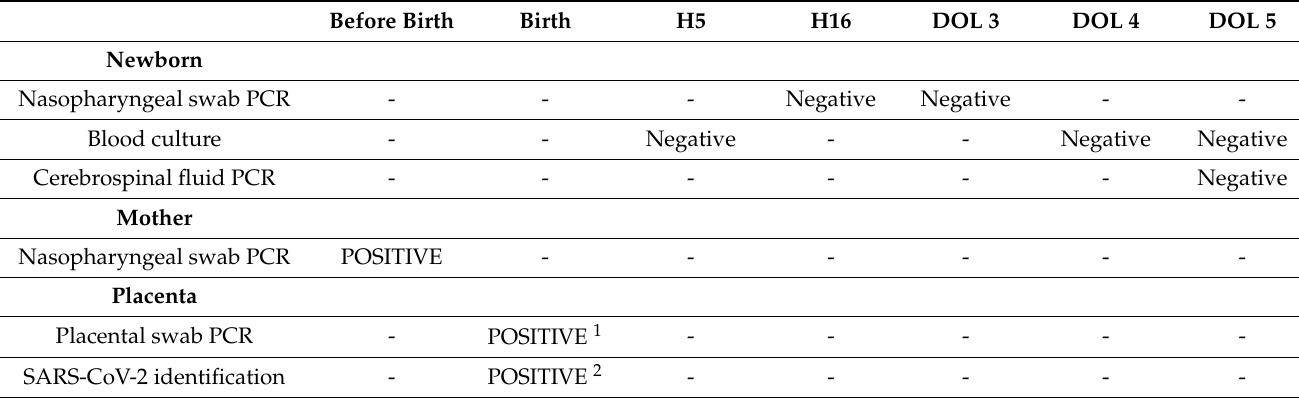
Table 2. Case 2: neonatal, maternal, and placental